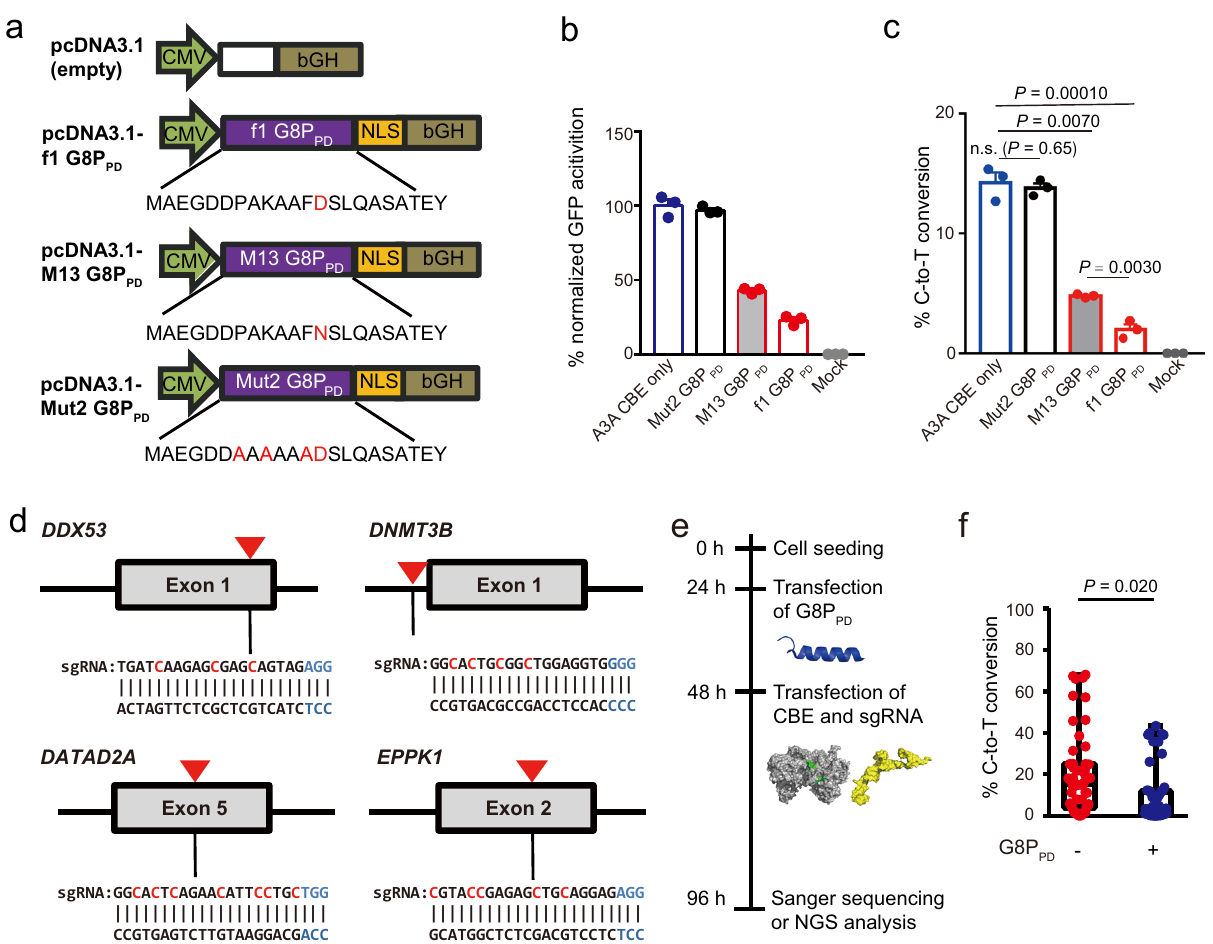
Fig. 1 G8PPD peptides inhibit CBE targeting of EGFP reporter and endogenous genomic sites in human cells. a The design of G8P PD plasmids for mammalian expression. b-c Analysis of the effects of G8P PD on A3A CBE using EGFP reporter cells. b Normalized fl ow cytometry results. c Next-generation sequencing analysis of C-to-T conversion. For b – c , the data are shown as mean ± standard error of mean (SEM) ( n = 3 biologically independent replicates). d Design of sgRNA targeted to DDX53, DNMT3B, GATAD2A and EPPK1 genomic loci. The PAM sequence and cytidines are highlighted in blue and red, respectively. Red arrows denote the positions of selected target sites. e Flow chart showing experimental procedures. The cartoons are blue for G8P PD , grey for CBE and yellow for sgRNA, respectively. f Analysis of the frequency of C-to-T conversion at all editing positions in the absence and presence of G8P PD . Each sgRNA contains 3 biologically independent replicates. The center line in each box indicates the median. The lower and upper bounds of each box represent the fi rst quartile (25%) and the third quartile (75%), respectively. The bottom and top of whiskers denote the minimum and maximum, respectively. For c and f , signi fi cant difference is determined using two-tailed Student ’ s t test. n.s., not signi fi cant. Source data are provided as a Source Data fi